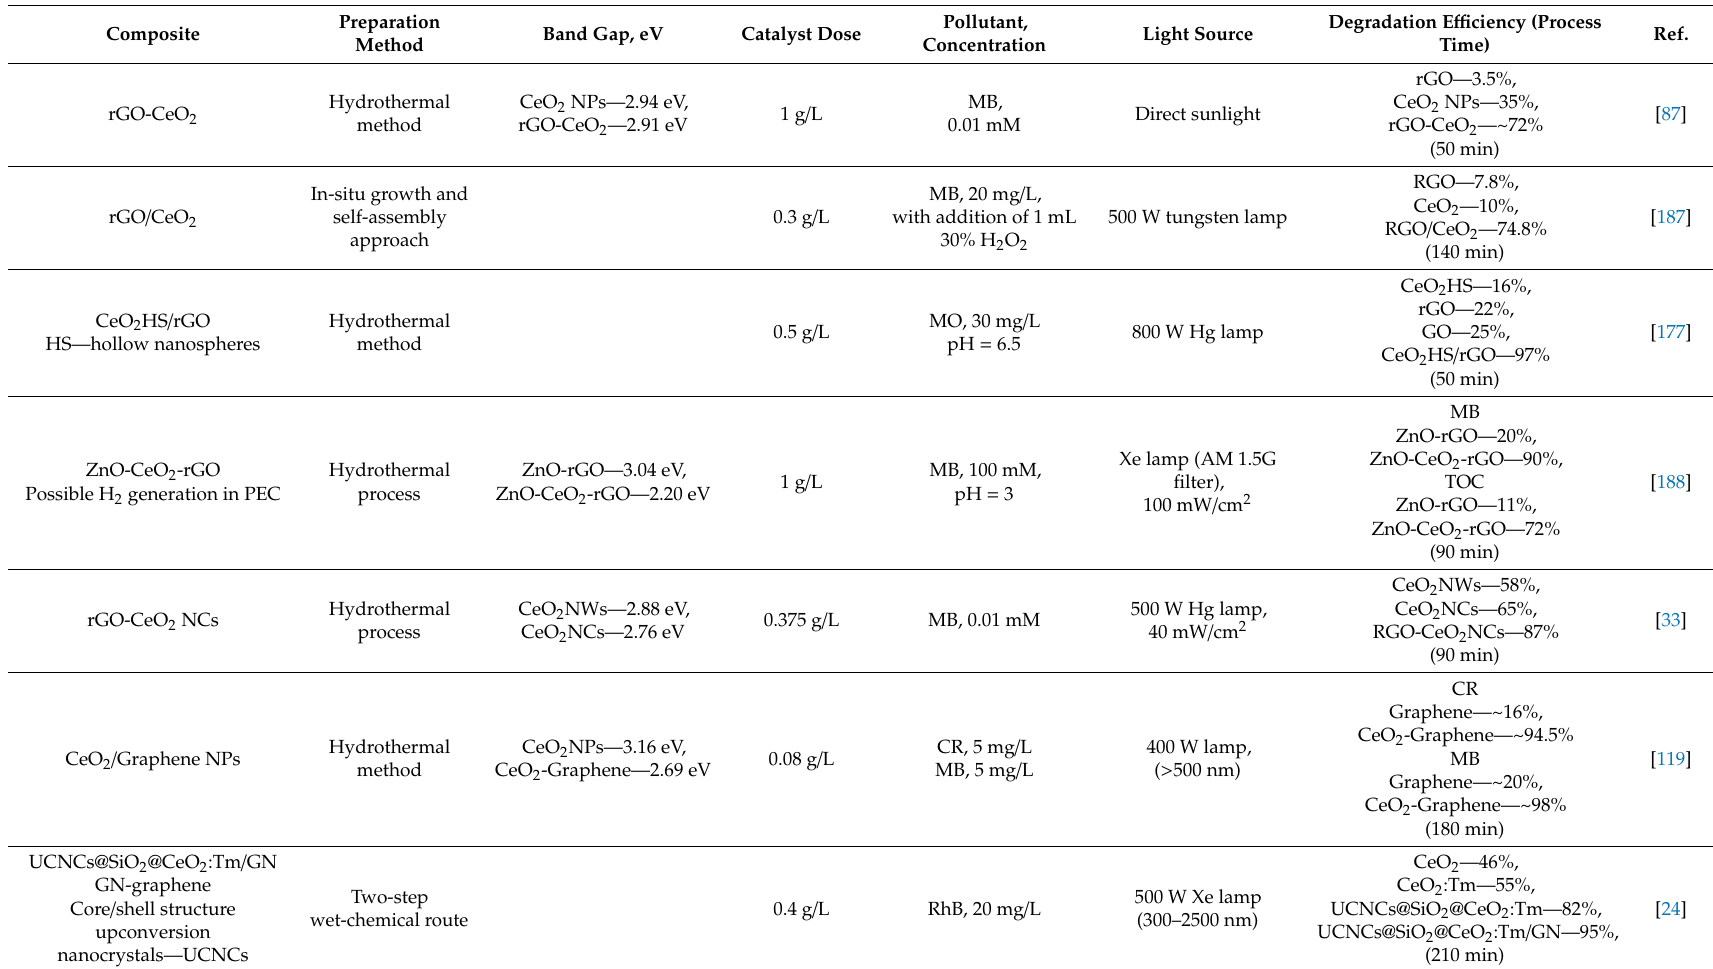
Table 4. Photocatalytic degradation of various pollutants with the application of CeO 2 composites with carbon